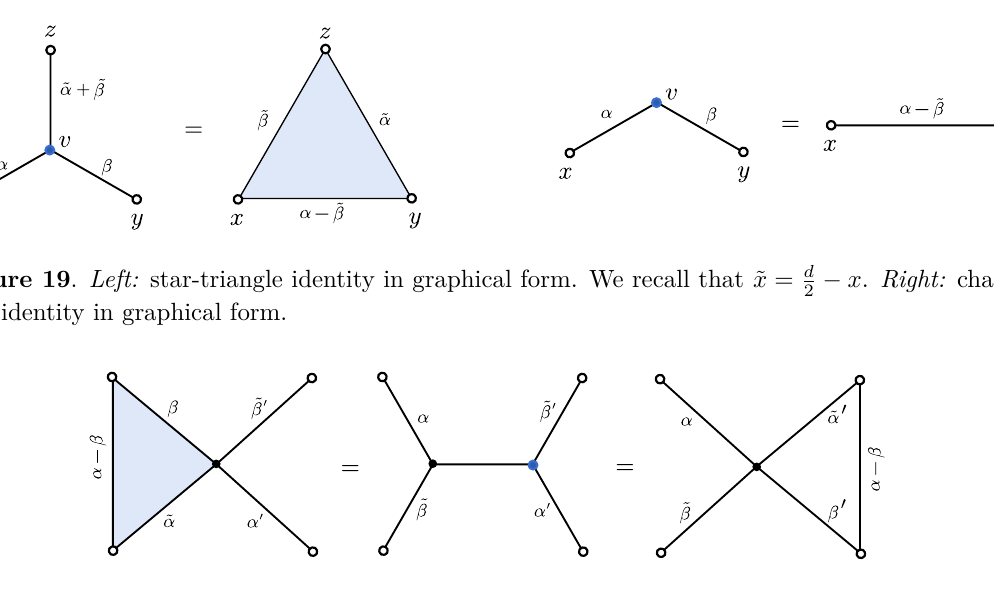
Figure 20 . The exchange relation corresponding to the notation of blue arrow used in the main text amounts to consecutive triangle-star and star-triangle transformations, and holds under the assumption α + β 0 = α 0 + β . The equalities hold modulo numerical coefficients depending on α, β, α 0 , β 0